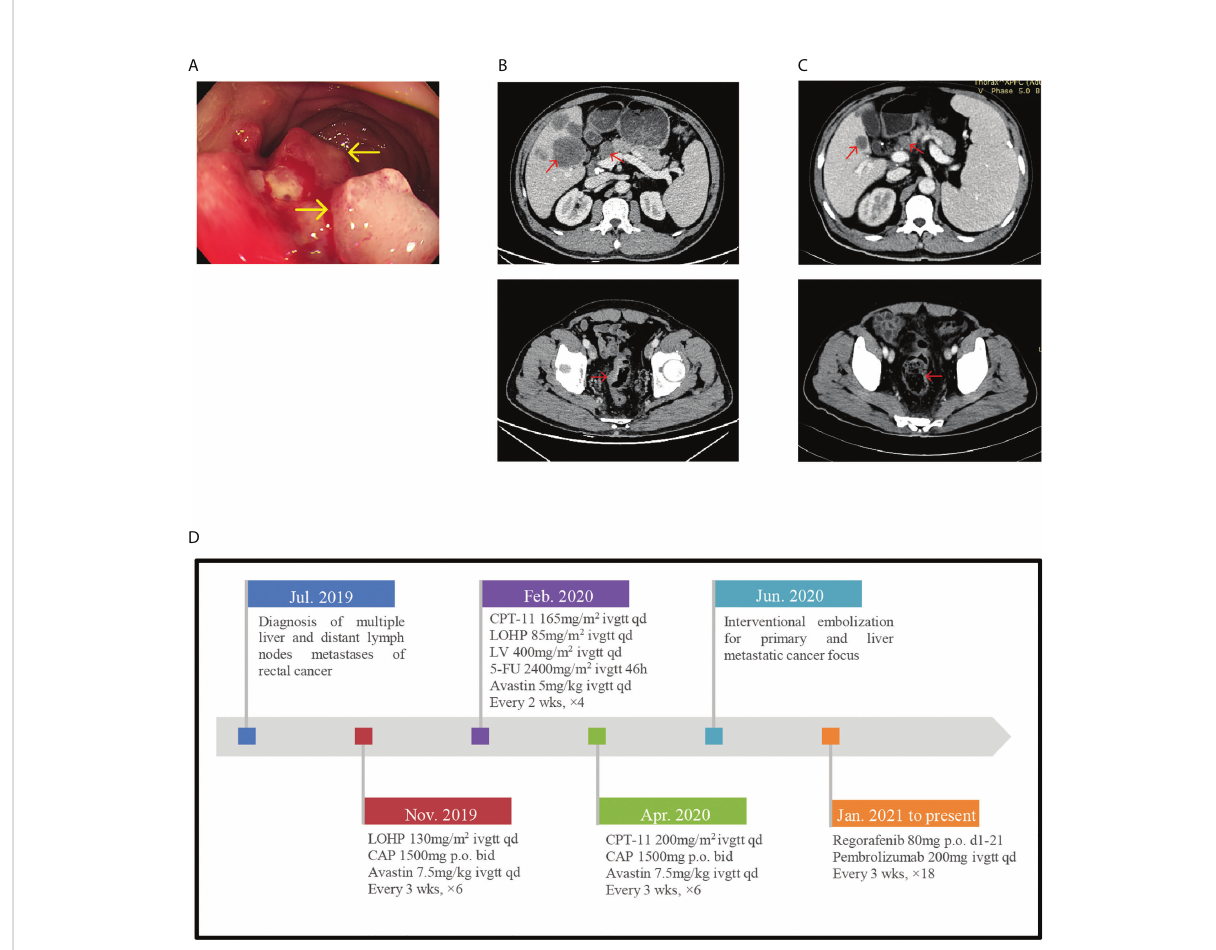
FIGURE 1 (A) Endoscope images showing rectal neoplasm. (B) In July 2019, pretreatment CT-scan showed the thickened colorectal wall and multiple liver and distant lymph nodes metastases. (C) CT-scan after 6 cycles of immunotherapy showed the tumor regression achieved partial response. (D) Timeline of diagnosis, detailed treatment protocol from July 2019 till